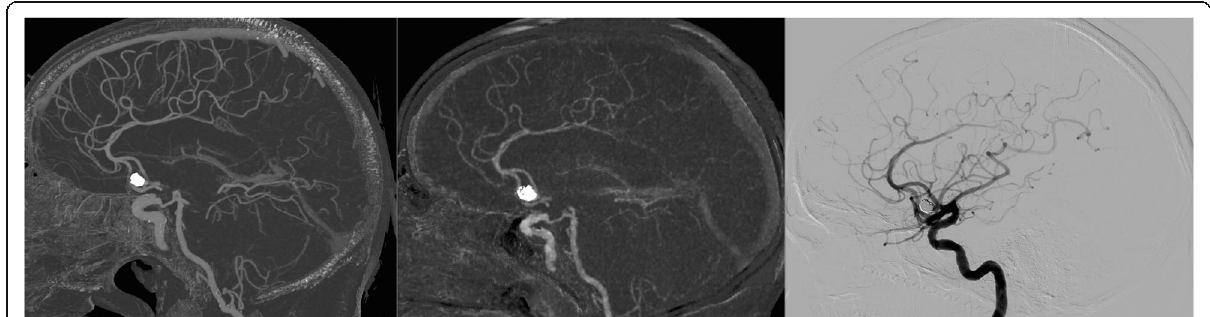
Fig. 4 Sixty-seven-year-old male treated with coil occlusion of an anterior communicating artery aneurysm (same patient as in Fig. 1). Follow-up with UHR subtraction CTA (left image), subtraction CTA on a conventional CT system (middle image), and conventional angiography (right image) demonstrated complete occlusion of the aneurysm, with only limited artifacts from the